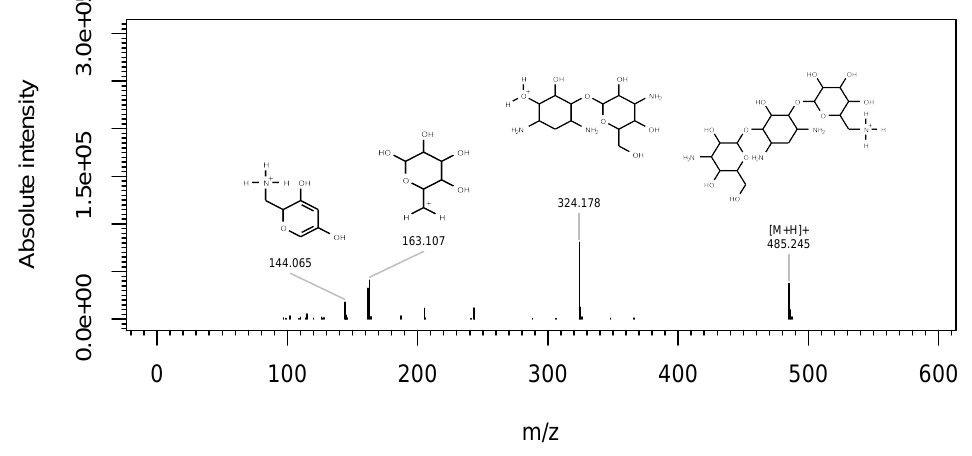
Figure A2. Challenge 2: annotated MS/MS spectrum of 1,2-bis-O-sinapoyl- β - D -glucoside (ESI, negative